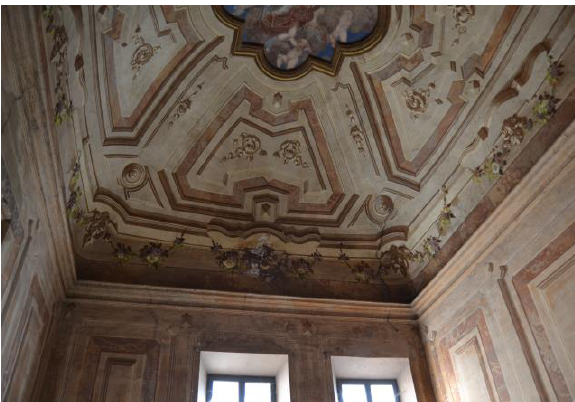
Figure 1. Magio Grasselli Palace: intrados of the staircase vault (Room